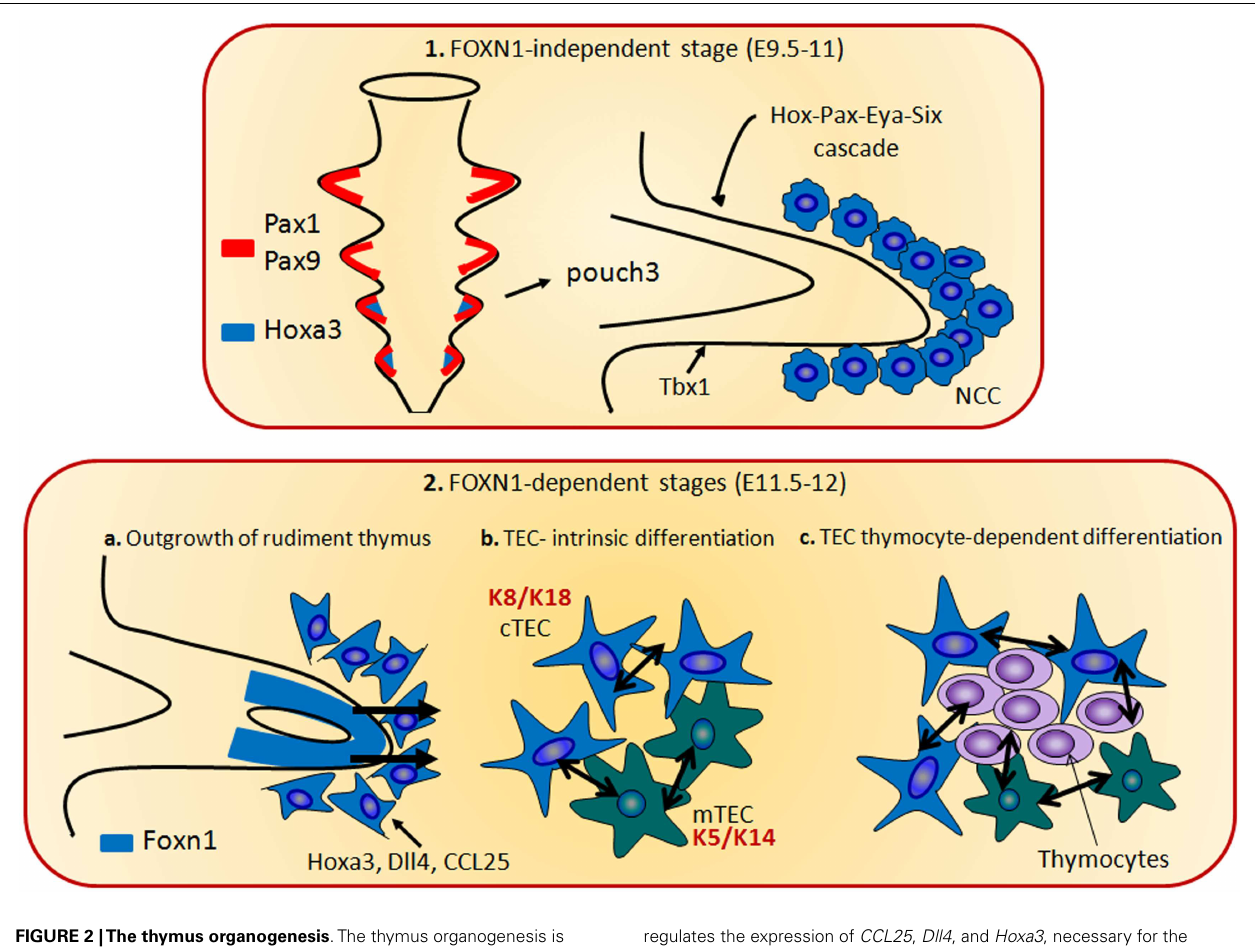
FIGURE 2 |The thymus organogenesis .The thymus organogenesis is characterized by two genetic phases.The first stage is independent from the Foxn1 expression (1) and consists in the induction and outgrowth of the thymic epithelial anlage from the third pharyngeal pouch, through the expression of genes including the Eya1 , Six , Hoxa3 , and Tbx1 . Hoxa3 and Eya1 are also required in neural crest cells (NCCs). In the phase 2, Foxn1